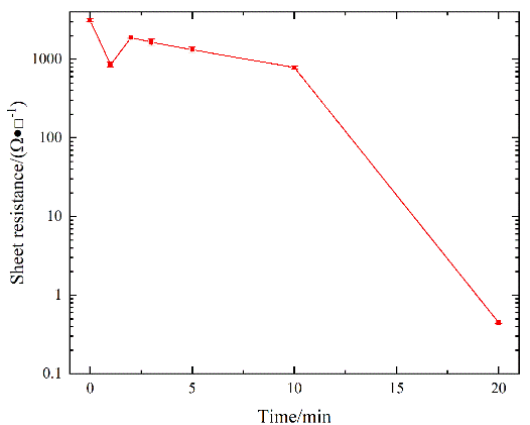
Figure 9. The sheet resistance curves of MnZn ferrite surface with different immersion